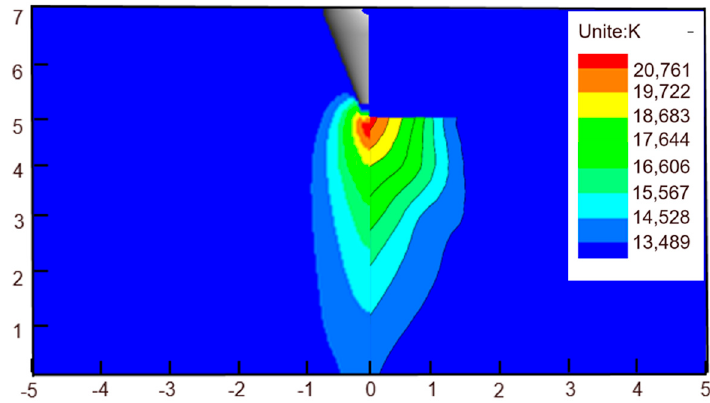
Figure 25. Arc temperature distribution in the simulated and experimental results.